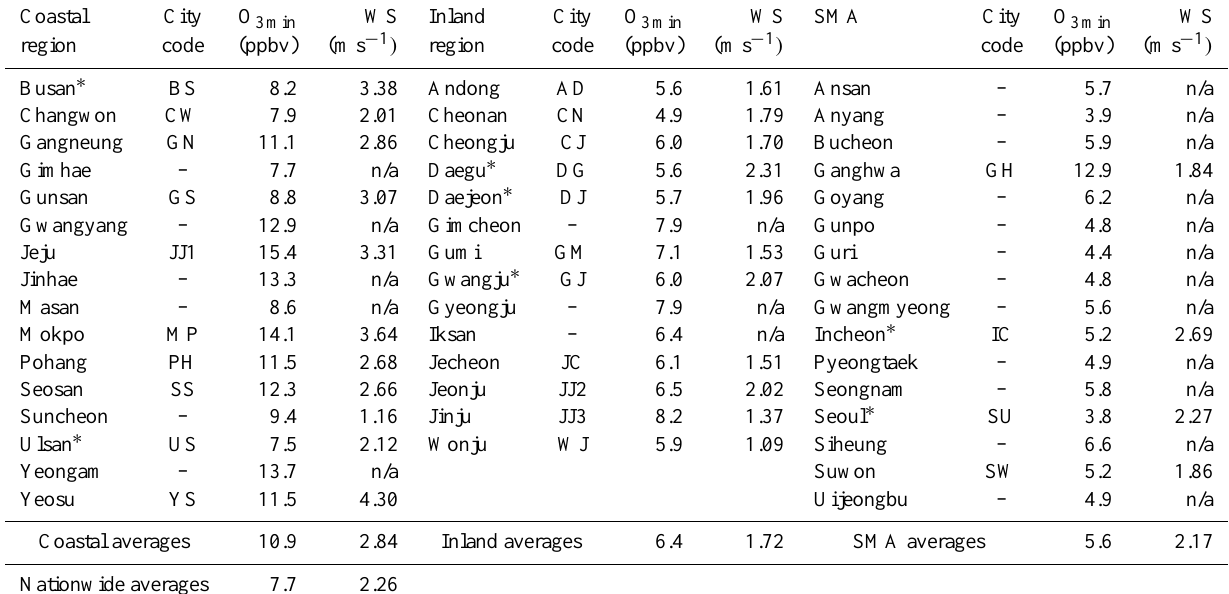
Table 3. 12yr averaged of daily minimum O 3 (O 3min ) concentrations and daily average WS at 46 cities over South Korea for the period 1999–2010. The cities are categorized into three groups: 16 coastal cities, 14 inland cities, and 16 cities in the SMA.